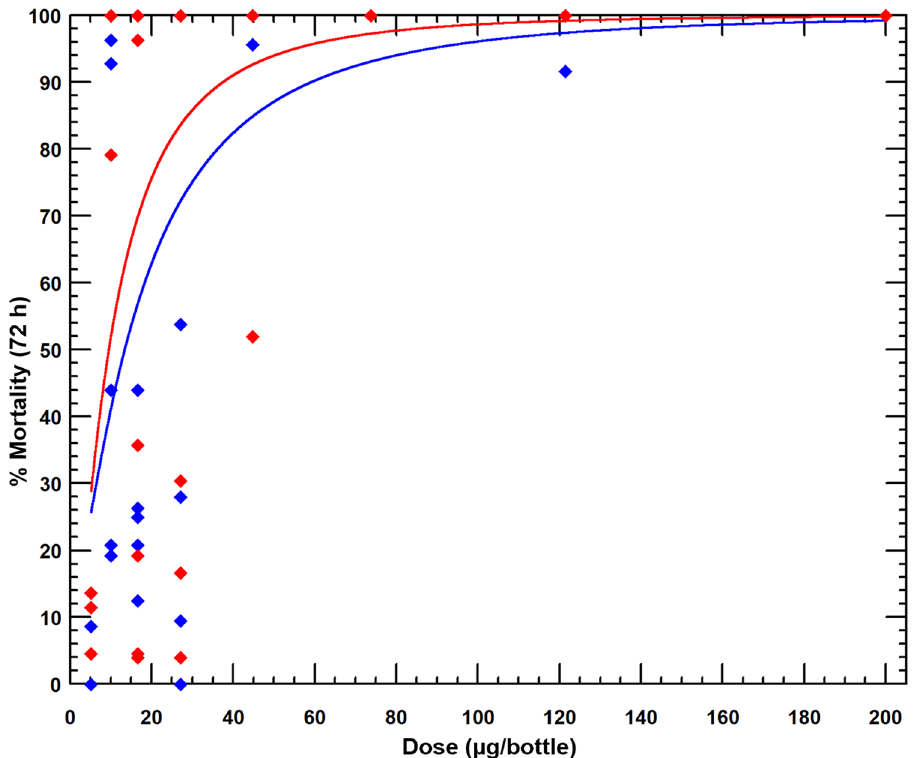
Figure 1. Mortality of susceptible An. gambiae Kisumu (red) and pyrethroid-resistant An. gambiae sl Covè (blue) mosquitoes in CDC bottle bioassays treated with a technical grade of broflanilide insecticide. Mosquitoes (150/dose) were exposed for 1-h in cohorts of 25 per bottle. Based on preliminary findings of delayed mortality effect with broflanilide, mortality in bottle bioassays was recorded after 72 h. The red line represents the response of the susceptible Kisumu strain while the blue line represents the response of the pyrethroid-resistant Covè strain. PoloPlus 1.0, LeOra Software.